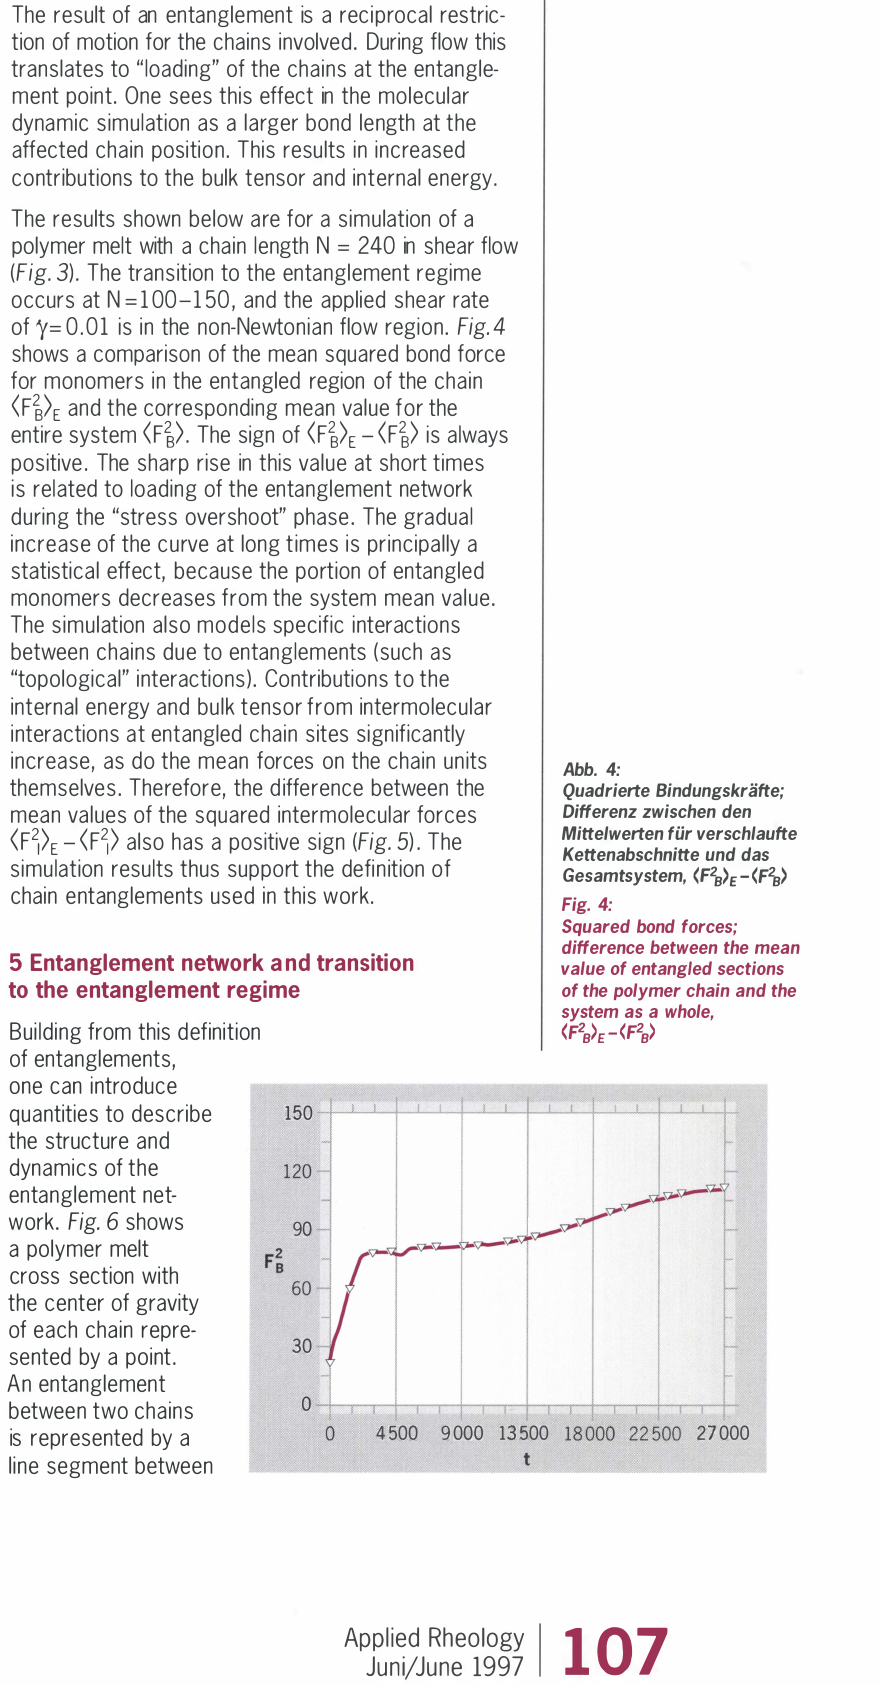
Fig. 3: Shear viscosity h as a function of time; chain length N = 240, shear rate y = 0.01; all quantities are in dimensionless units.